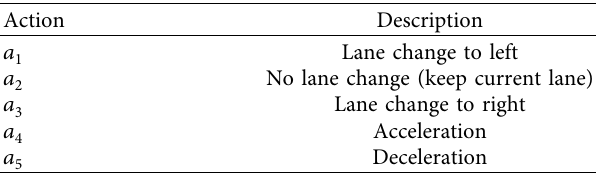
Table 1: Action space of